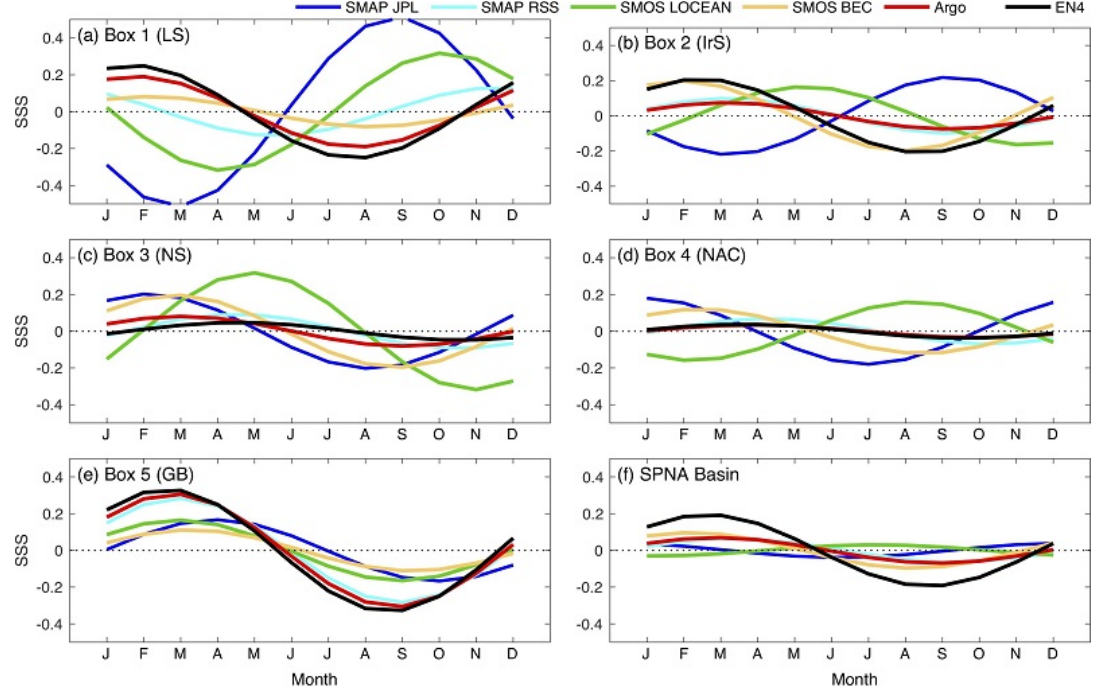
Figure 7. The estimated annual cycles averaged over the five selected boxed areas depicted in Figure 1b and the entire basin. ( a ) Box 1. LS: The Labrador Sea. ( b ) Box 2. IS: The Irminger Sea. ( c ) Box 3. NS: The Nordic Seas. ( d ) Box 4. SPG: The Subpolar Gyre. ( e ) Box 5. NFL: Newfoundland. ( f ) The entire subpolar North Atlantic basin.